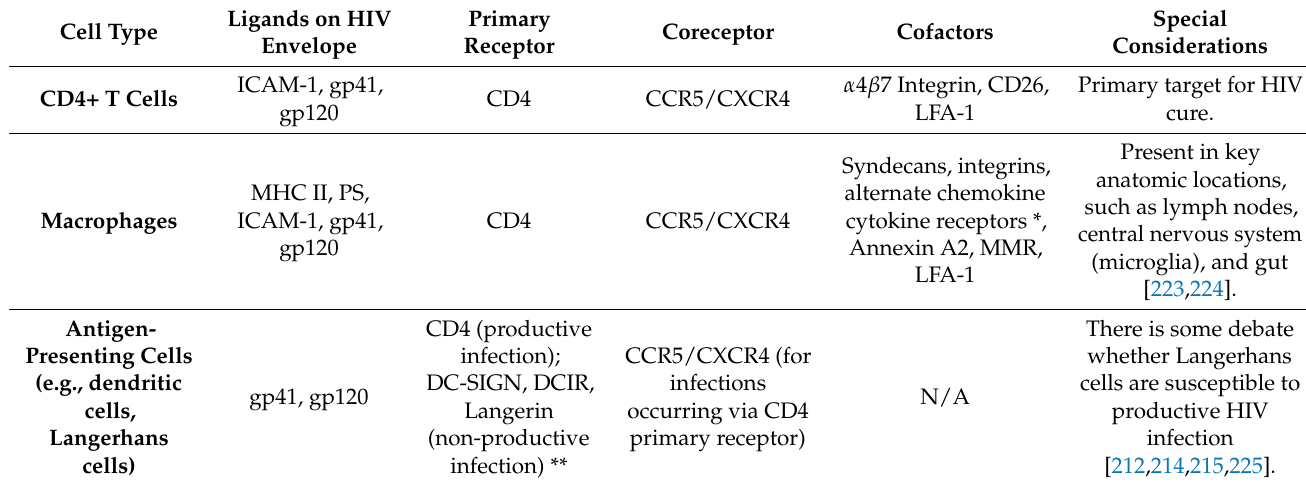
Table 3. HIV receptors, coreceptors, and